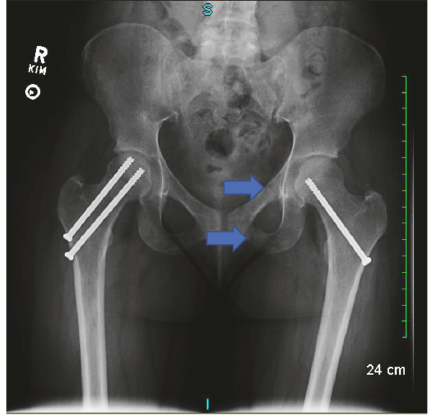
Figure 2: X-ray of the hips and femurs . New insufficiency fractures (arrows) were noted. There was interval placement of stabilizing screws for the previous right and left femoral neck insufficiency